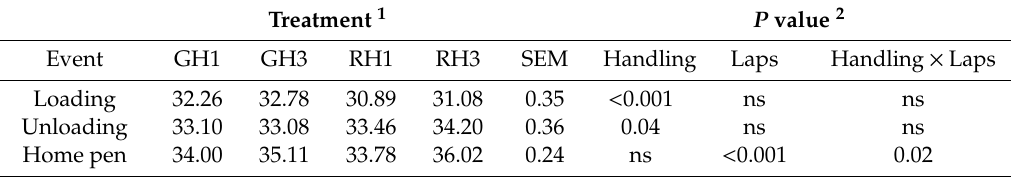
Table 2. Least square means of infrared body surface temperature by treatment and